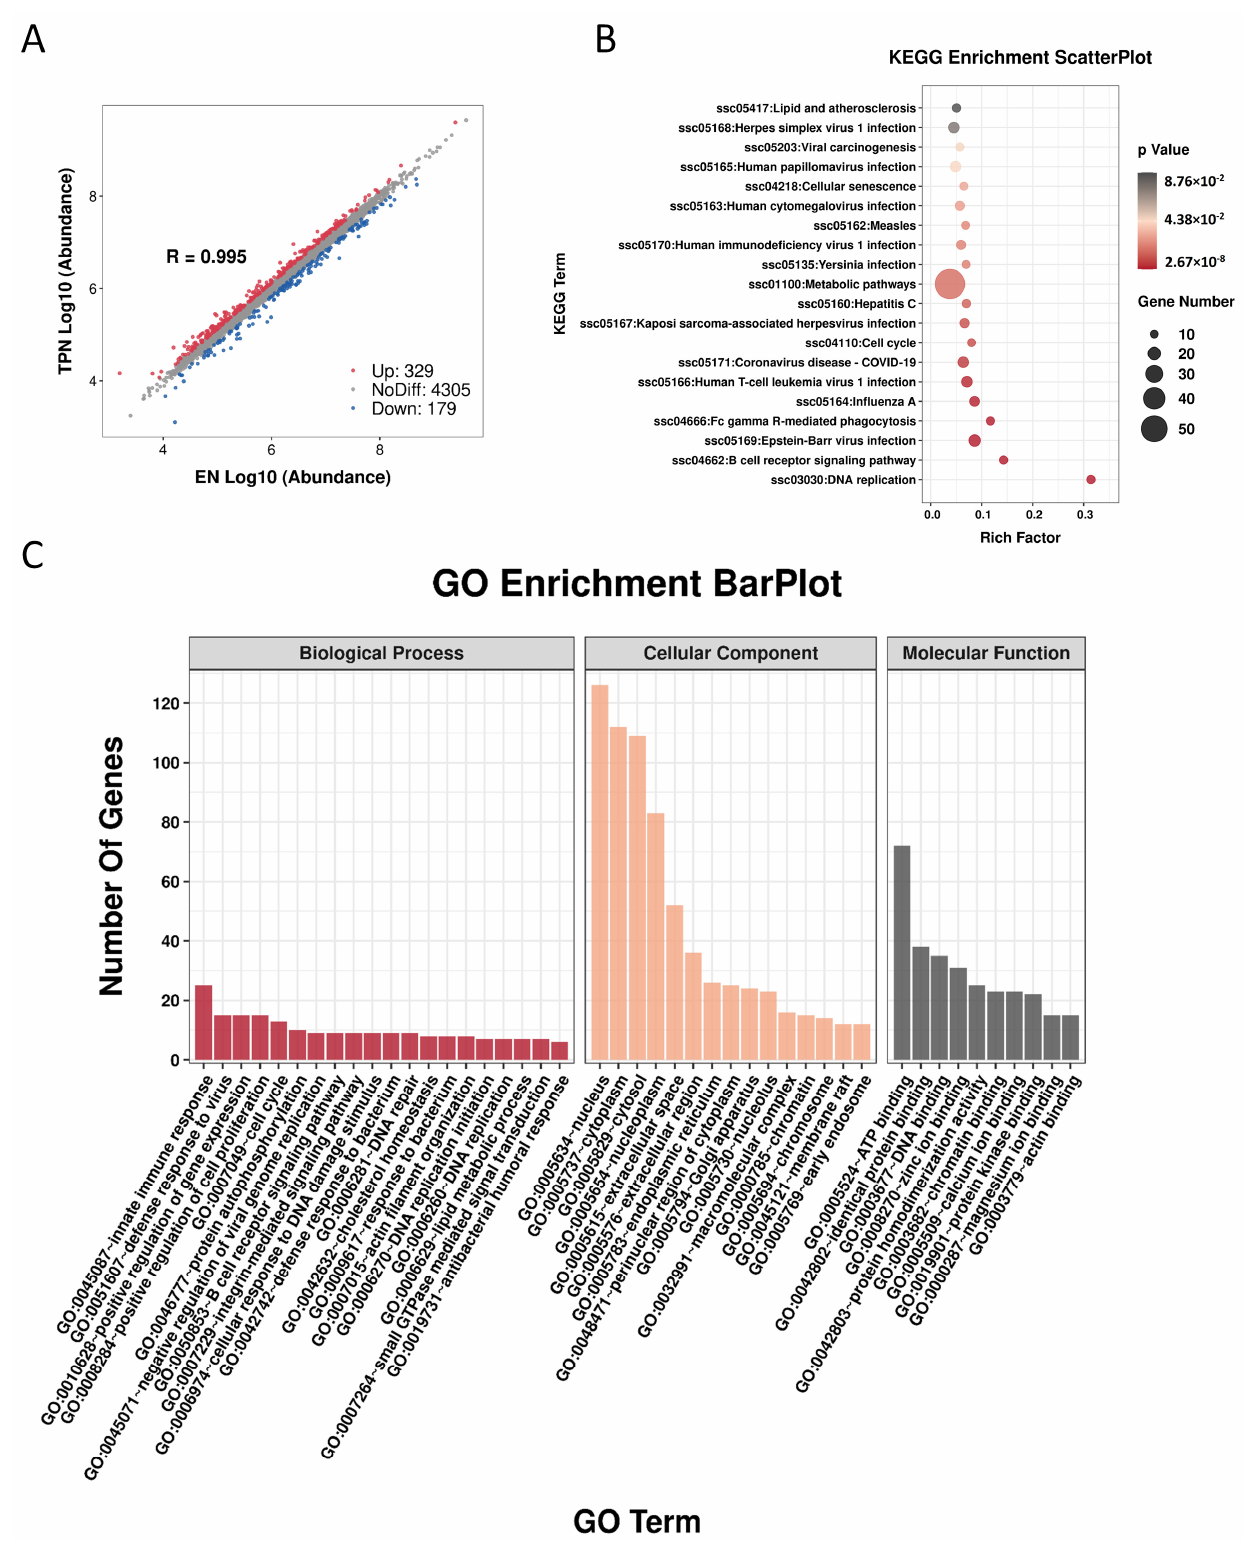
Figure 3. Proteomic profile in the ileum epithelium. ( A ) Scatter plotting of differential proteins. ( B ) KEGG pathway enrichment analysis of differential proteins. ( C ) Gene Ontology (GO) enrichment analysis of differential